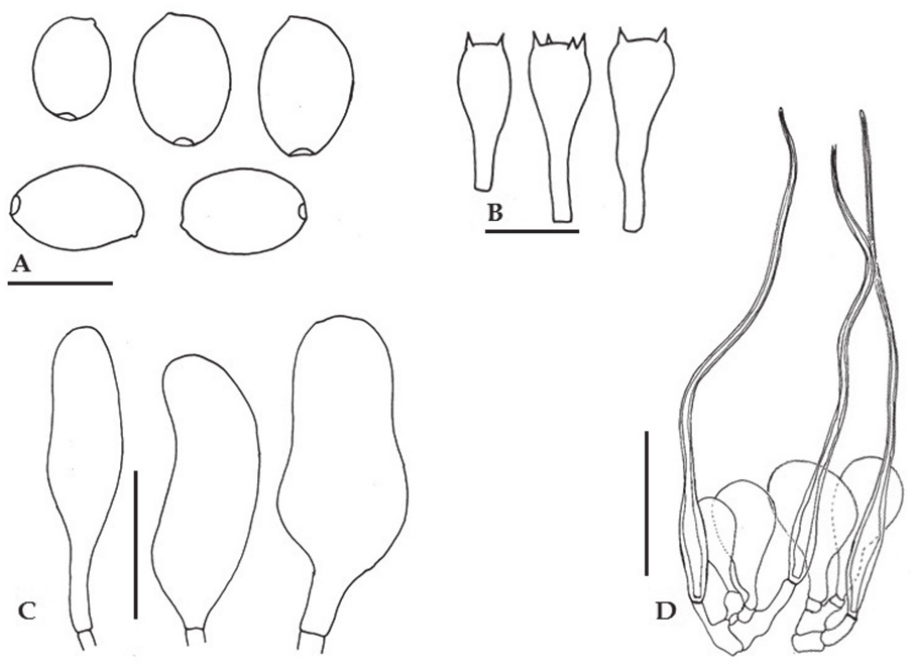
Figure 8. Anatomical features of Parasola auricoma (LAH-SHP-7). A Basidiospores B Basidia C Cheilo- cystidia D Pileipellis. Scale bars: A = 10 µm, B–D = 20